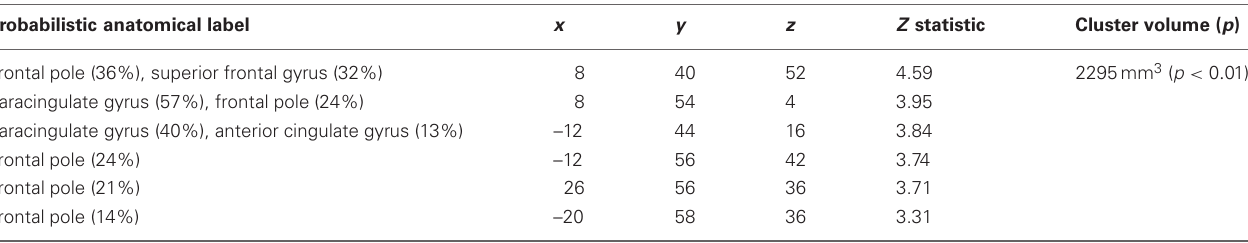
Table 3 | Regions showing significantly activation positively correlated with symptom index scores following promotion (ideal) priming trials compared to control priming